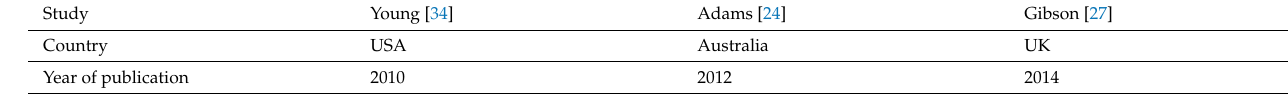
Table 1. Main characteristics of studies investigating the association between vitamin D-related genetic variations and nonalcoholic fatty liver disease included in the systematic